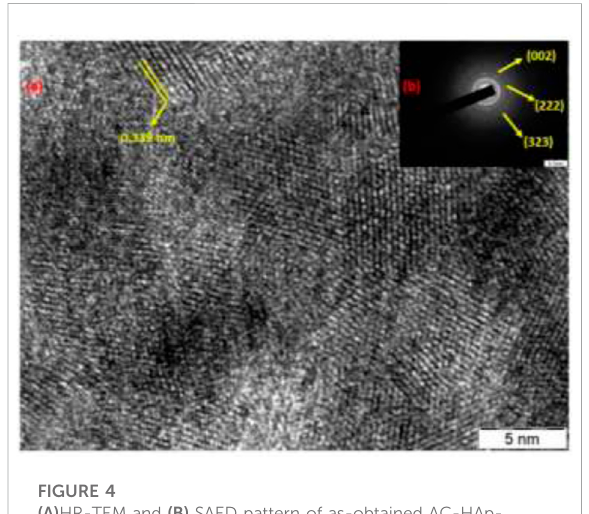
FIGURE 4 (A) HR-TEM and (B) SAED pattern of as-obtained AC-HAp- NPs